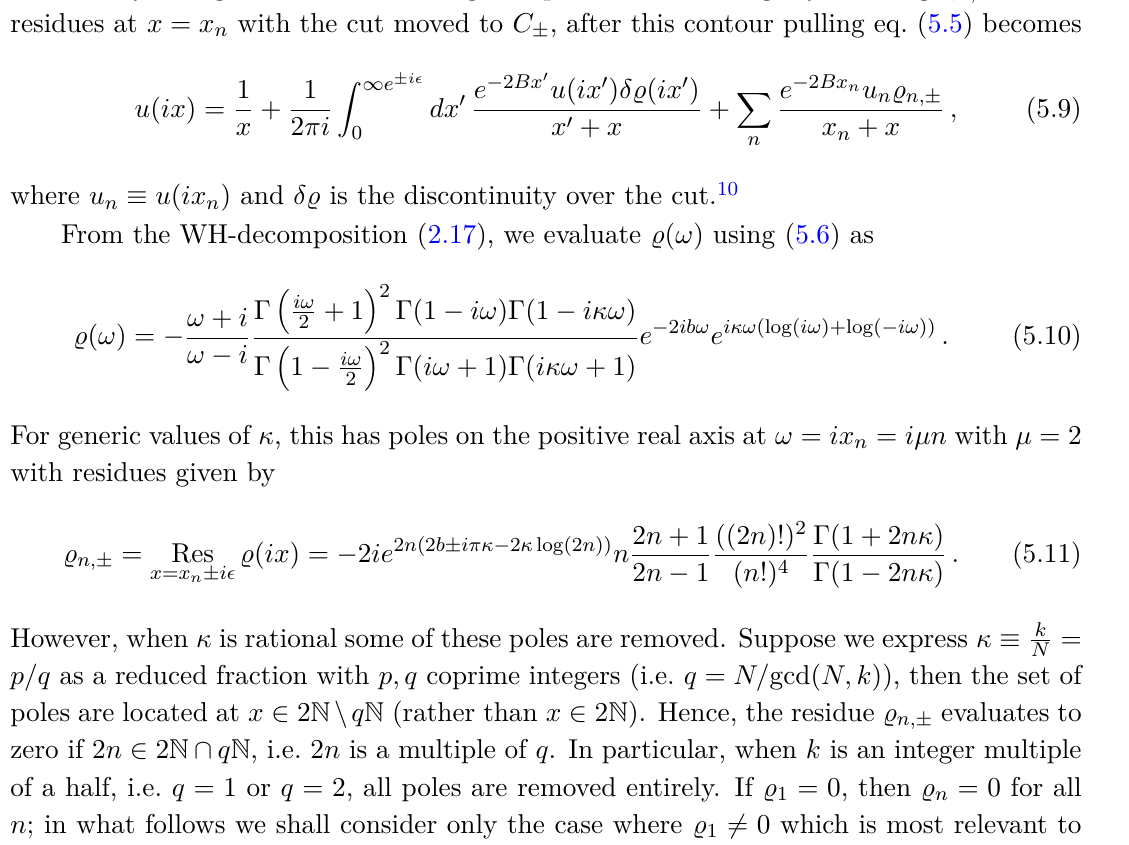
or C . In those cases respectively, the + − , but their values differ by n